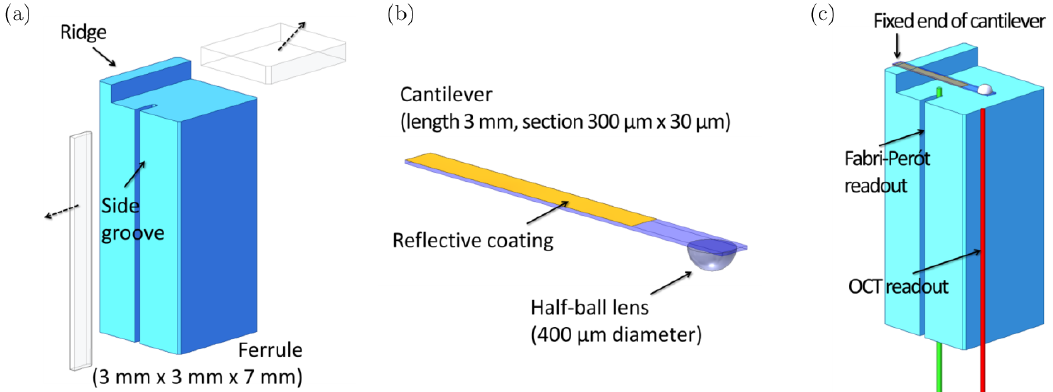
Fig. 2. OCE Ferrule-top fabrication steps: The ferrule is showed upside-down to ease the visualization. (a) preparation of the ferrule (micromachining of the ridge and of the side groove); (b) preparation of the cantilever; and (c) assembly of the two readout ¯bers and of the